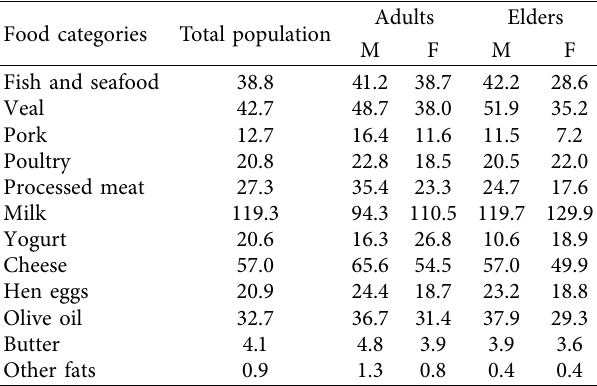
Table 1: Daily intake of food items (gday − 1 ) by the Italian pop- ulation for two different sex/age classes (adults and